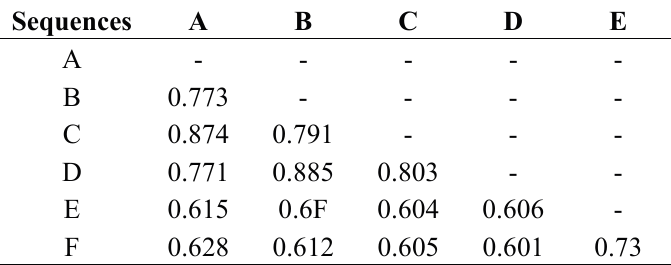
Table 2. DNA similarity matrix of geosmin and MIB-related cnb genes in cyanobacteria (1398 bp).